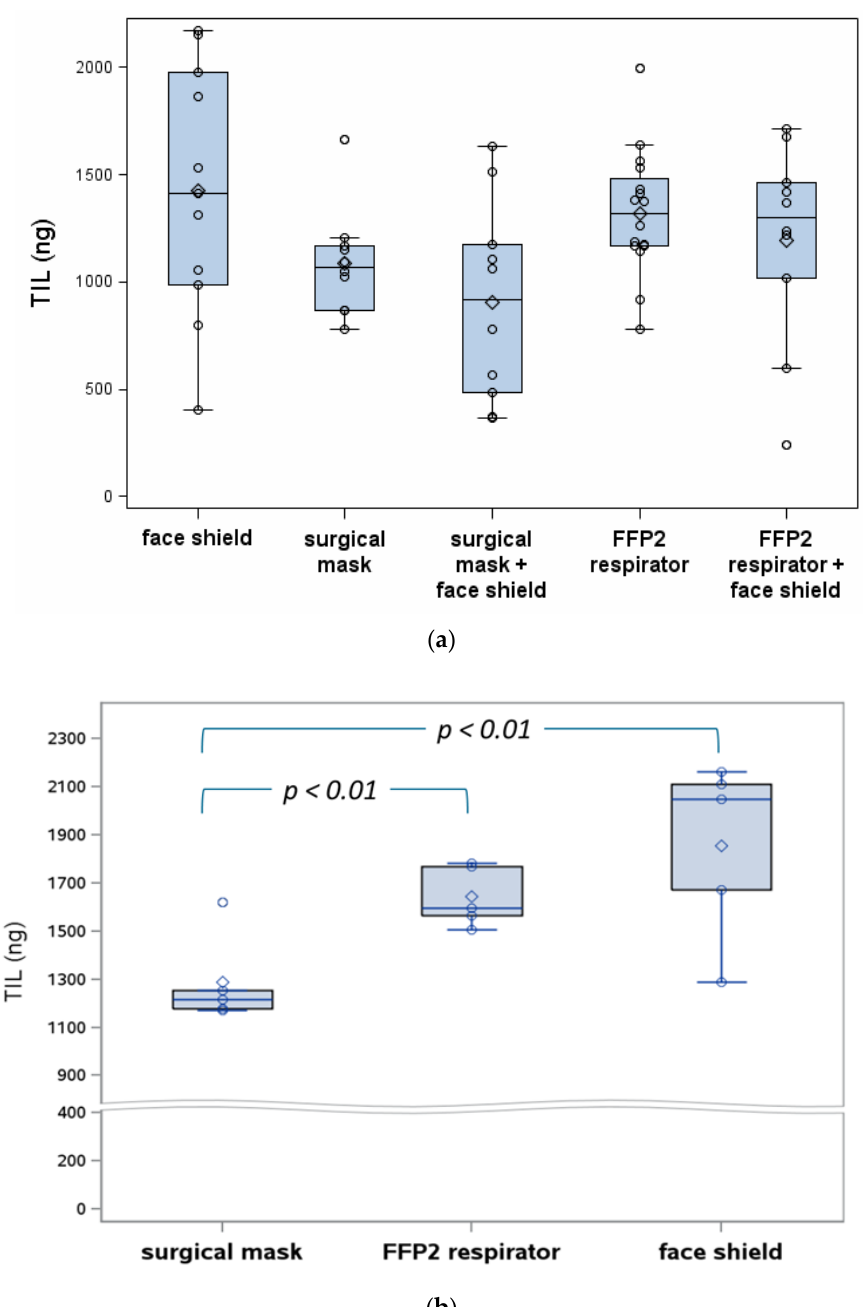
Figure 3. TIL expressed as recovered fluorescein at 30 cm ( N = 10 – 16) ( a ) and 60 cm ( N = 5) ( b ). The diamonds correspond to the